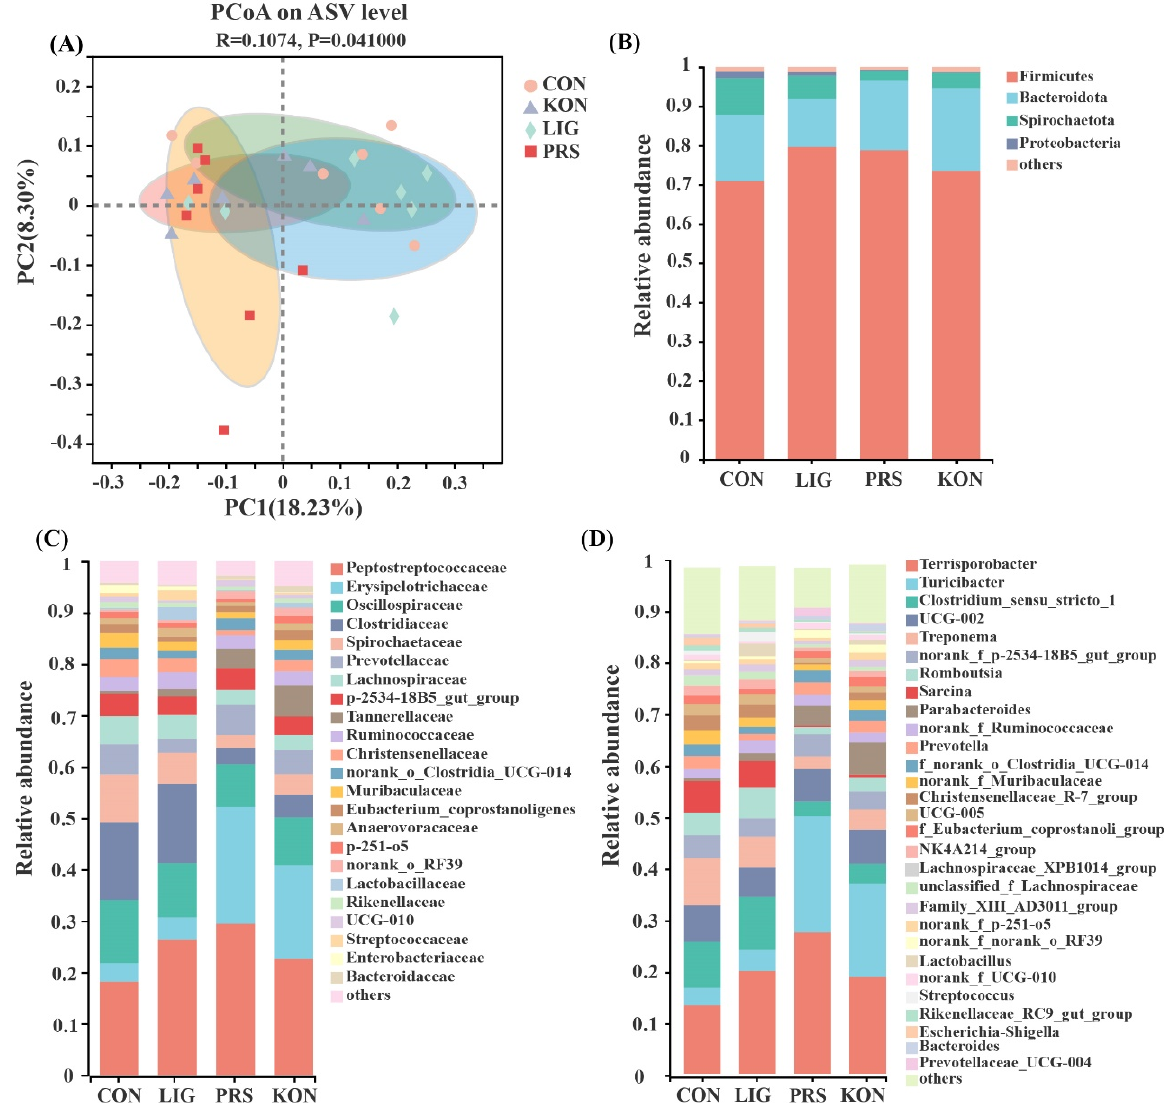
Figure 4. Comparison of the composition of the fecal microbiome ( n = 7). The principal coordinate analysis (PCoA) plots of the four groups ( A ). Microbial structure at the phylum level ( B ), family level ( C ), and genus level ( D ) in the feces of sows. CON, control; LIG, lignocellulose; PRS, resistant starch; KON, konjaku flour.